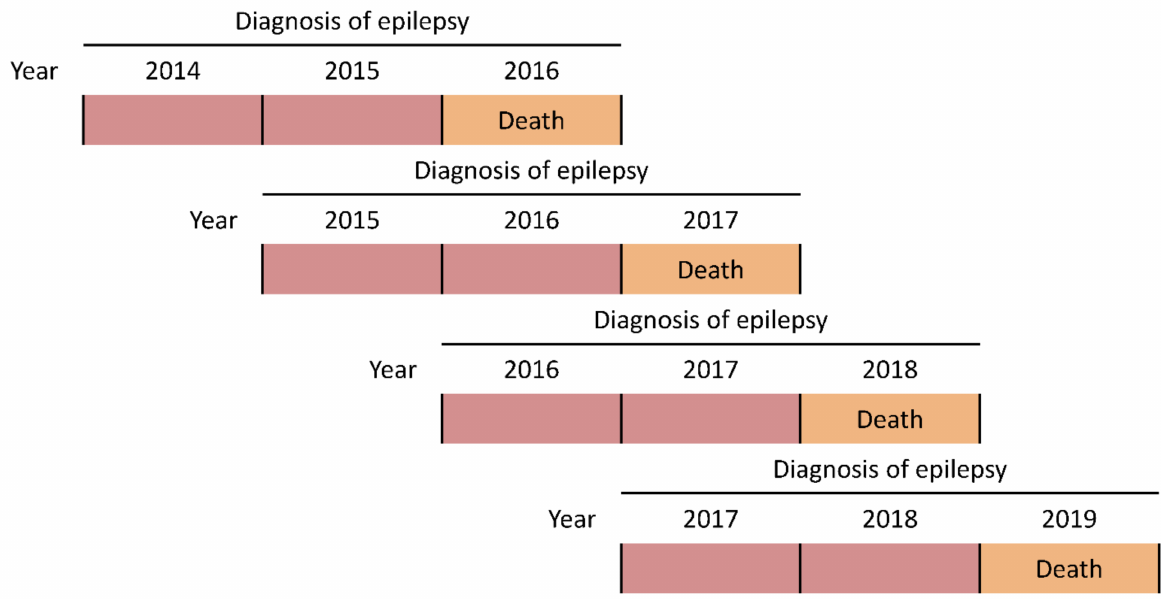
Figure 1. Each year from 2016 to 2019, PWE were included if they were documented to have G40 the year of analysis (orange) and/or anytime two years before (red). The rate of death was compared between PWE and the general population every different year. Table 1. Data sources used in the study. The study covered a population of 2.8–2.9 million country residents